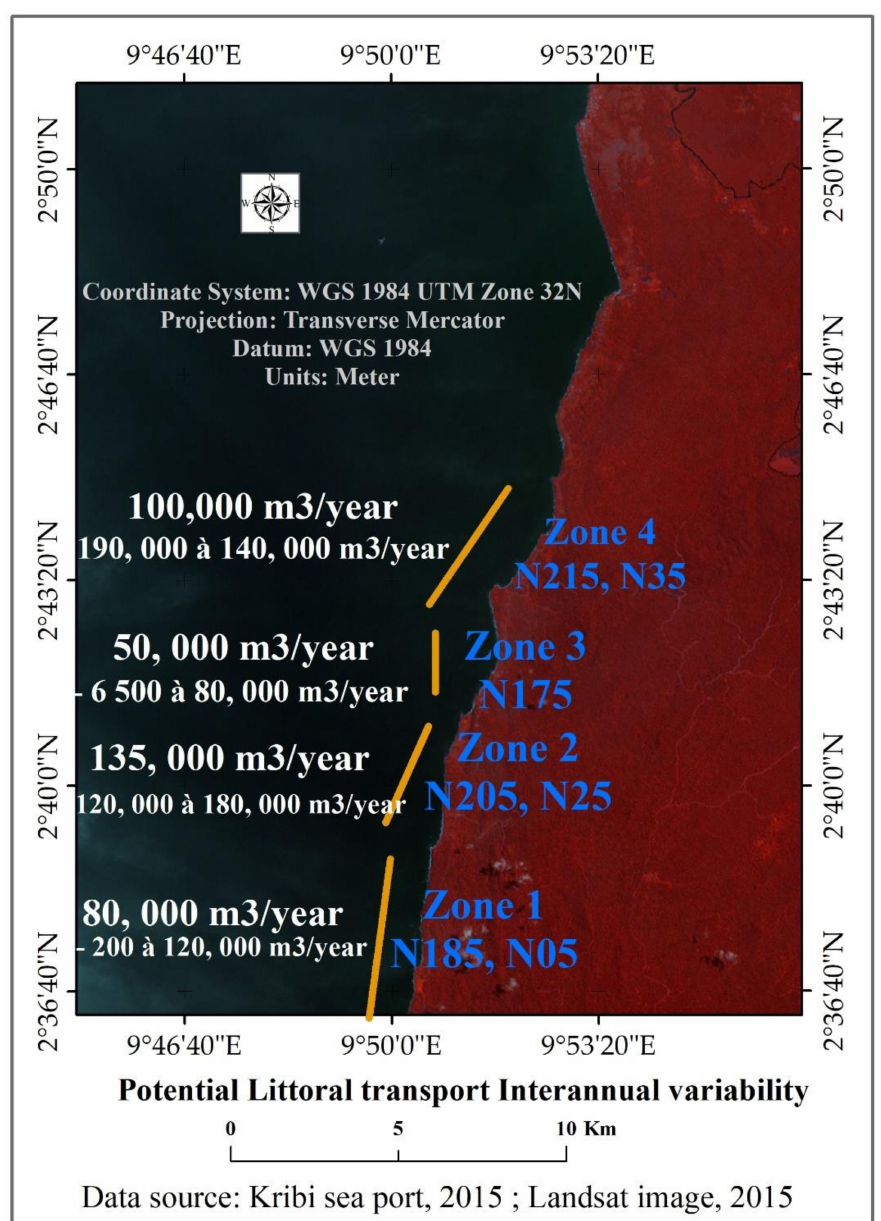
Figure 9. Coastal drift and sediment transport on a portion of the Kribi coast (Source: